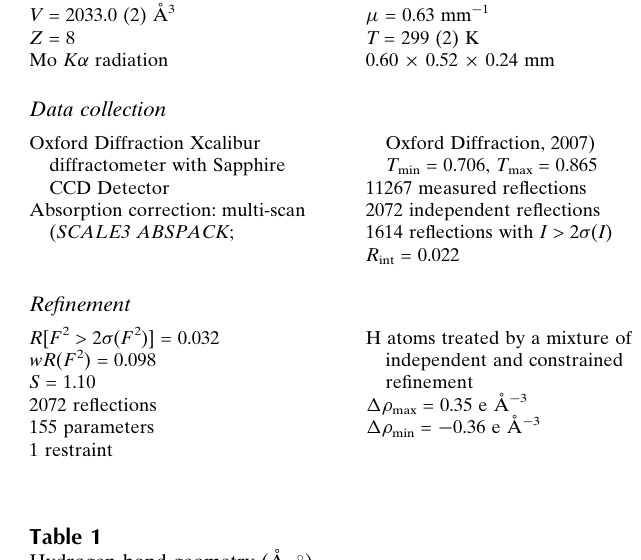
Hydrogen-bond geometry (A˚ , (cid:4)